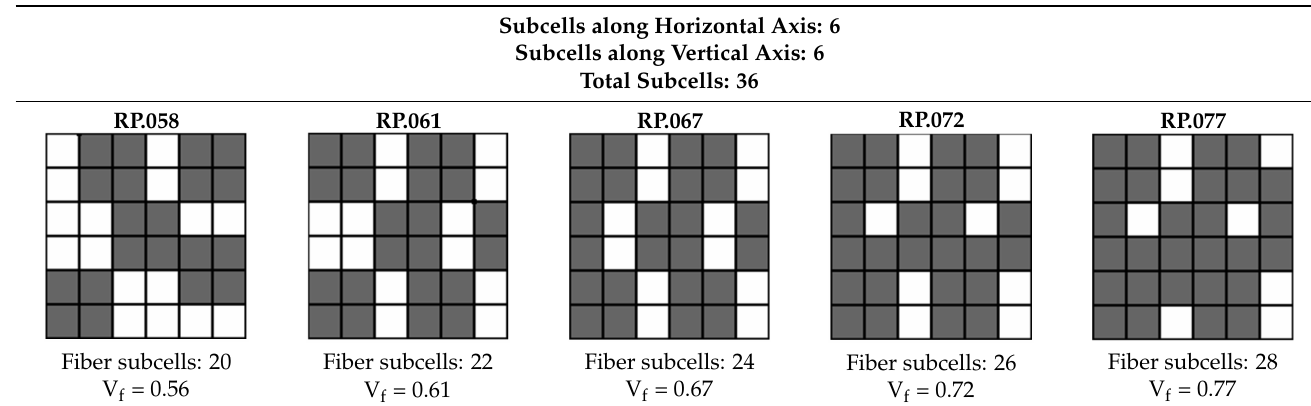
Table 3. Random packaging arrangements with various V f